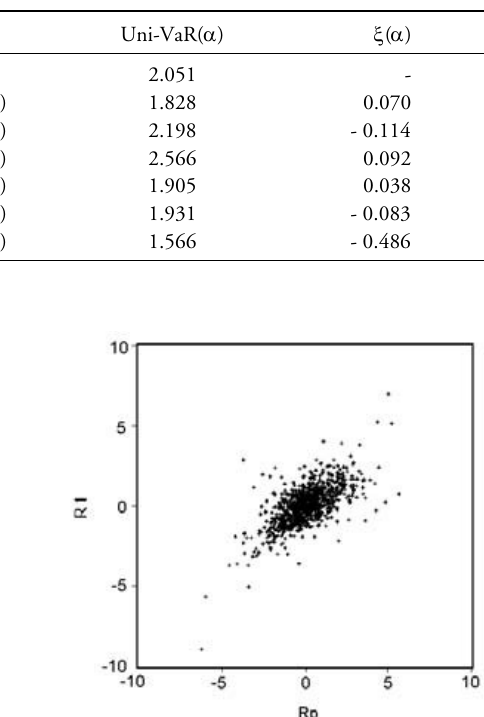
Measures of market risk: β , β -VaR( α ), (and relative rankings within parentheses), Uni-VaR( α ) and ξ ( α ) non-linear tail dependency measure.